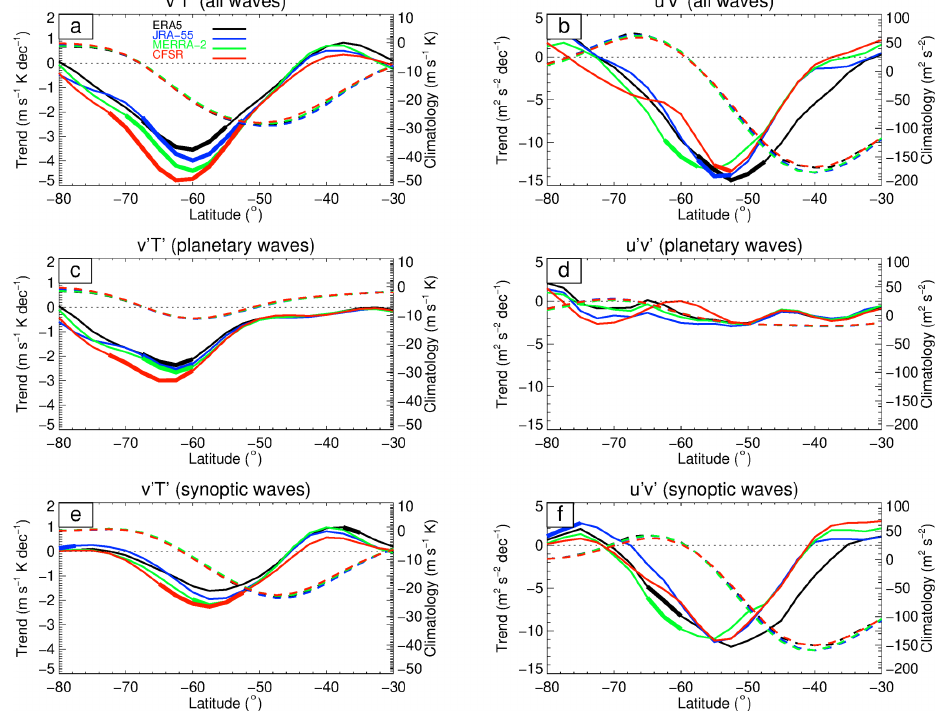
Figure 8. DJF trend and climatological mean in vertically integrated zonally eddy heat flux v (cid:48) T (cid:48) from 30 to 300hPa (left column) and eddy momentum flux u (cid:48) v (cid:48) from 100 to 500hPa (right column) due to all waves (a, b) , planetary waves (c, d) , and synoptic waves (e, f) from 1980 to 2001 for ERA5 (black), JRA-55 (blue), MERRA-2 (green), and CFSR (red). The trend in v (cid:48) T (cid:48) is indicated by the solid lines (left y axis; units: ms − 1 K per decade) and the climatological mean by the dashed lines (right y axis; units: ms − 1 K). The trend in u (cid:48) v (cid:48) is indicated by the solid lines (left y axis; units: m 2 s − 2 per decade) and the climatological mean by the dashed lines (right y axis; units: m 2 s − 2 ). Thick solid lines denote latitudes where the trends are significant at the 5% significance level. Note that for both columns the right and left axes have different